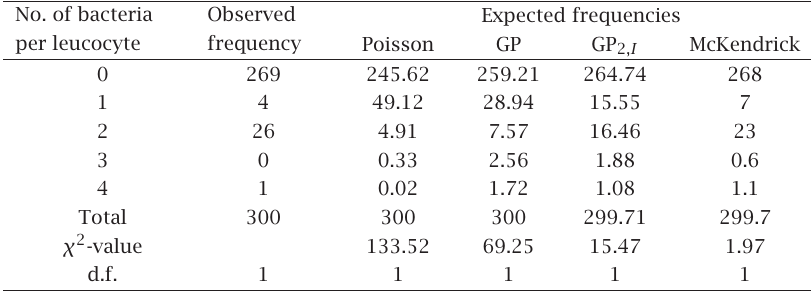
Table 4.1 . Distribution of the counts of bacteria in